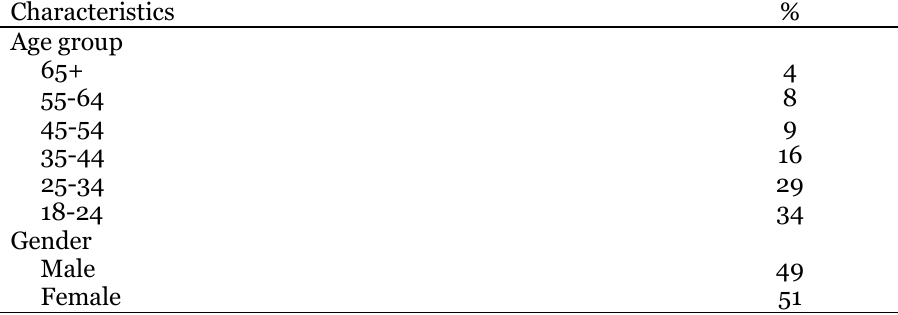
Age and Gender of NTU OCW Users